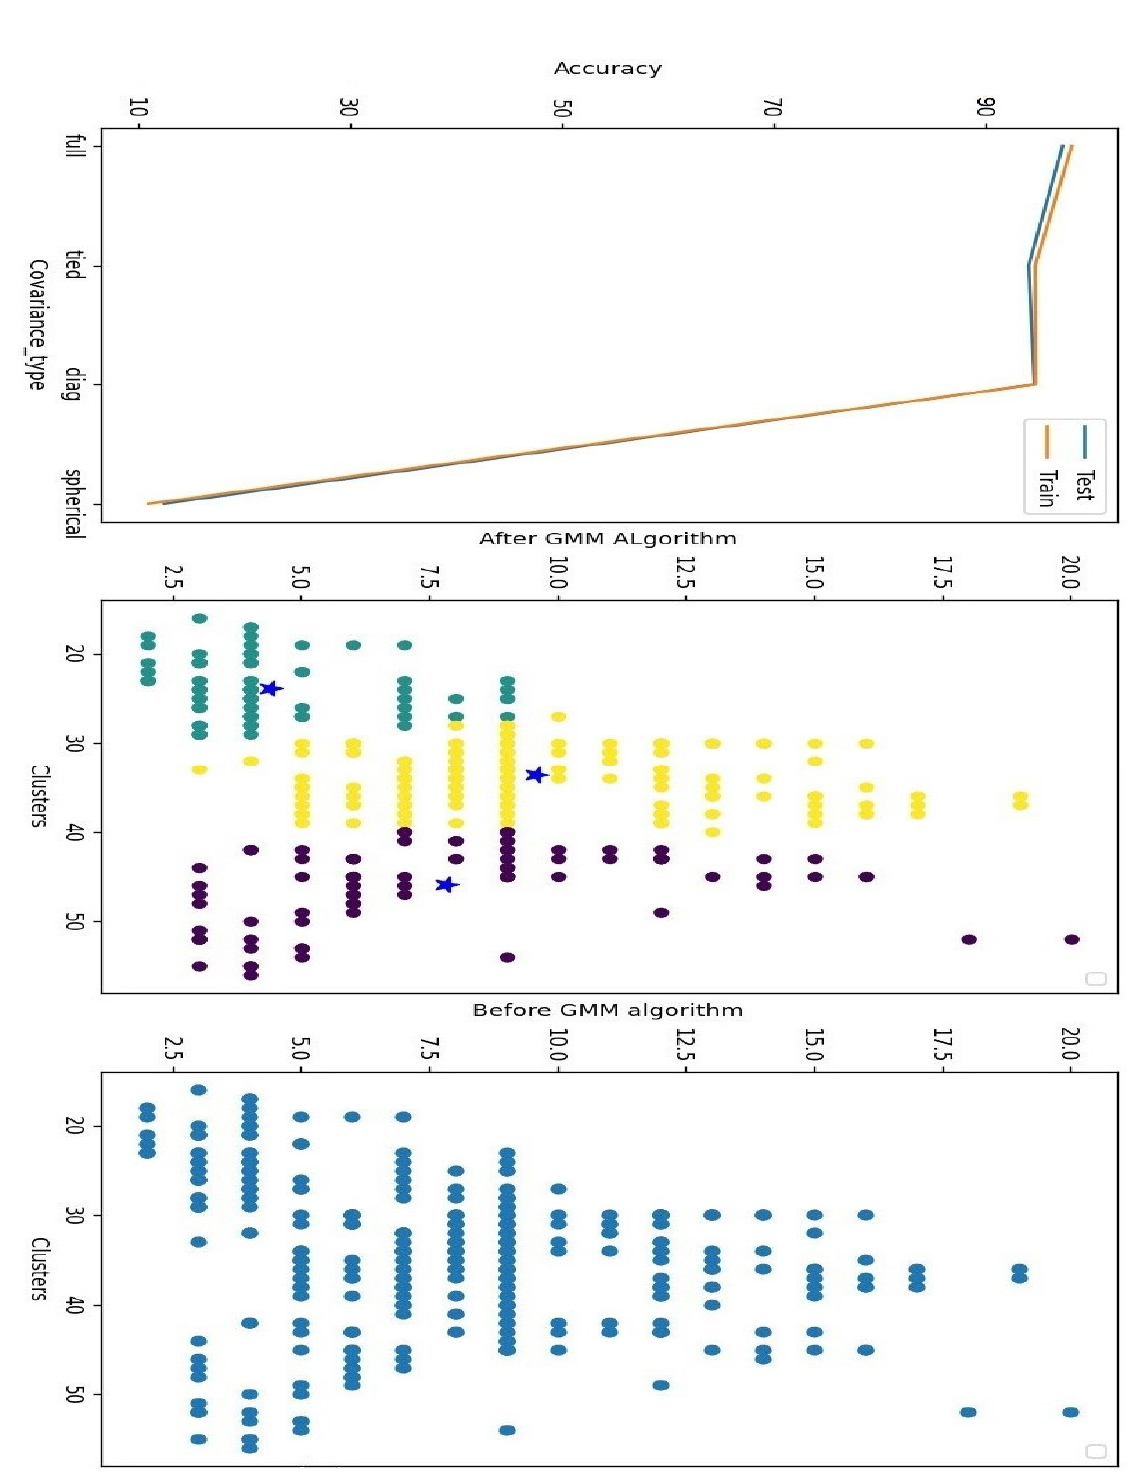
Figure 3. GMM algorithm output based on Iran data (source: authors’ calculations based on Python programming).